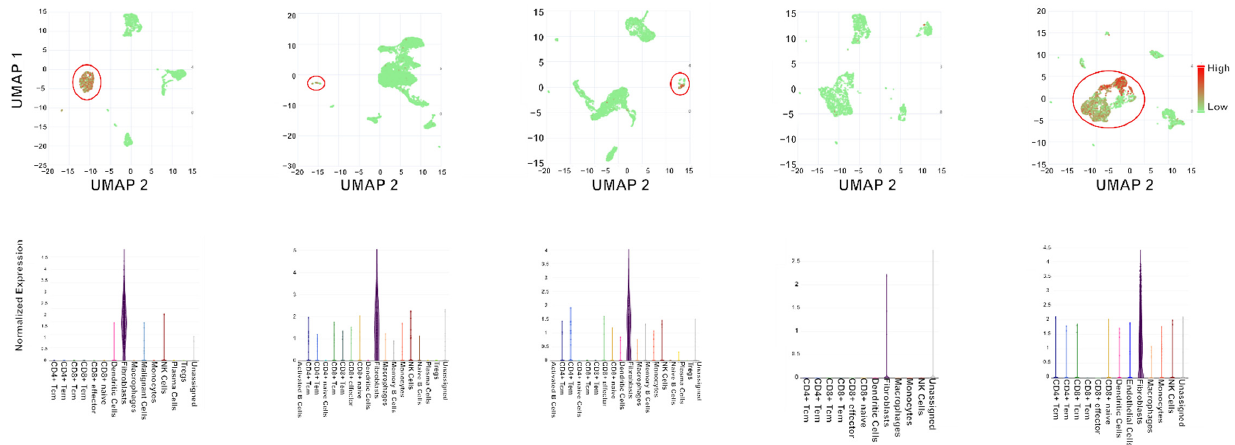
Figure 5. Single-cell RNA-sequencing results identify cell types that express MEG3 . Expression profile of MEG3 in 5 ATC patient tumors represented as UMAPs with overlaid heatmaps demonstrating MEG3 expression and expression in different cell subtypes in each sample. Red circles represent clusters of cells that are annotated as fibroblasts.